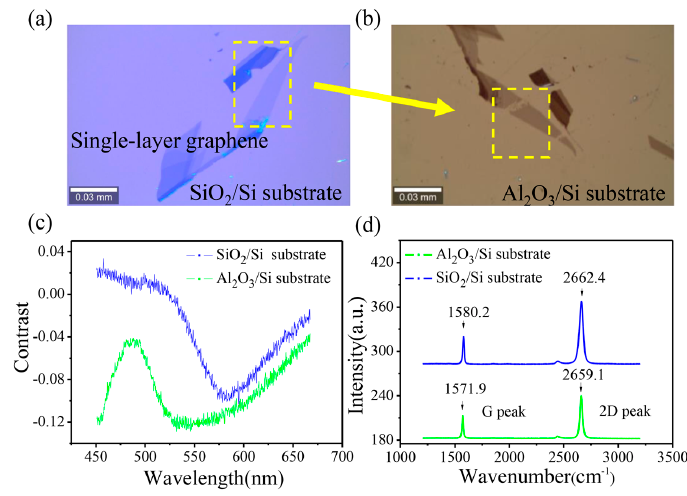
Figure 3. ( a , b ) Optical image of graphene on the SiO 2 /Si and Al 2 O 3 /Si substrates. ( c ) The contrast and ( d ) Raman spectra of graphene on SiO 2 /Si and Al 2 O 3 /Si substrates. Raw data and processing methods are shown in Figures S2 and S3.